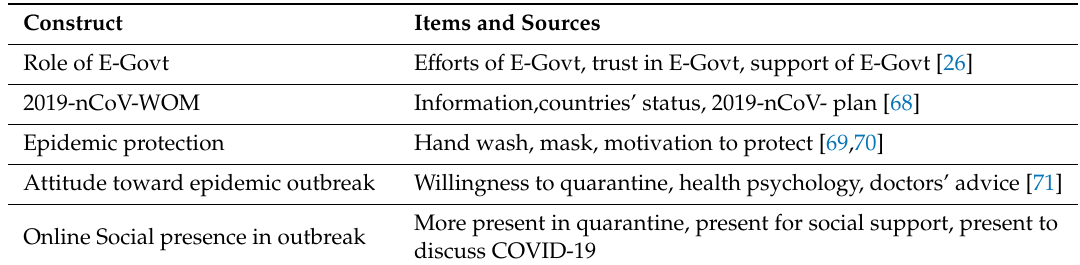
Table 2. Scale development.